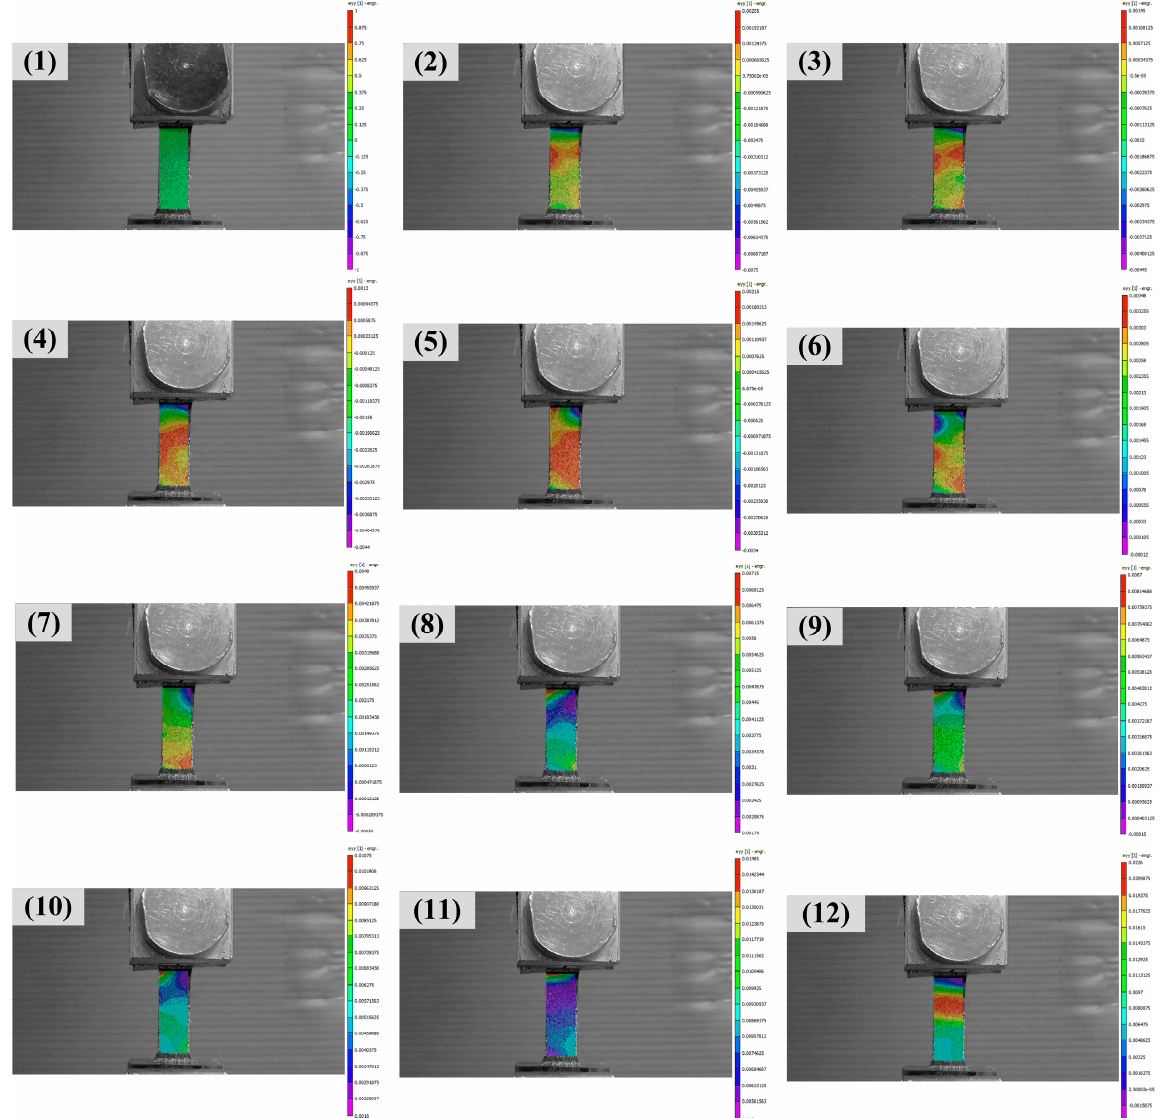
Figure 4. The strain history of specimen under quasi-static loading determined by DIC method. ( 1 )–( 12 ) the whole deformation process of the